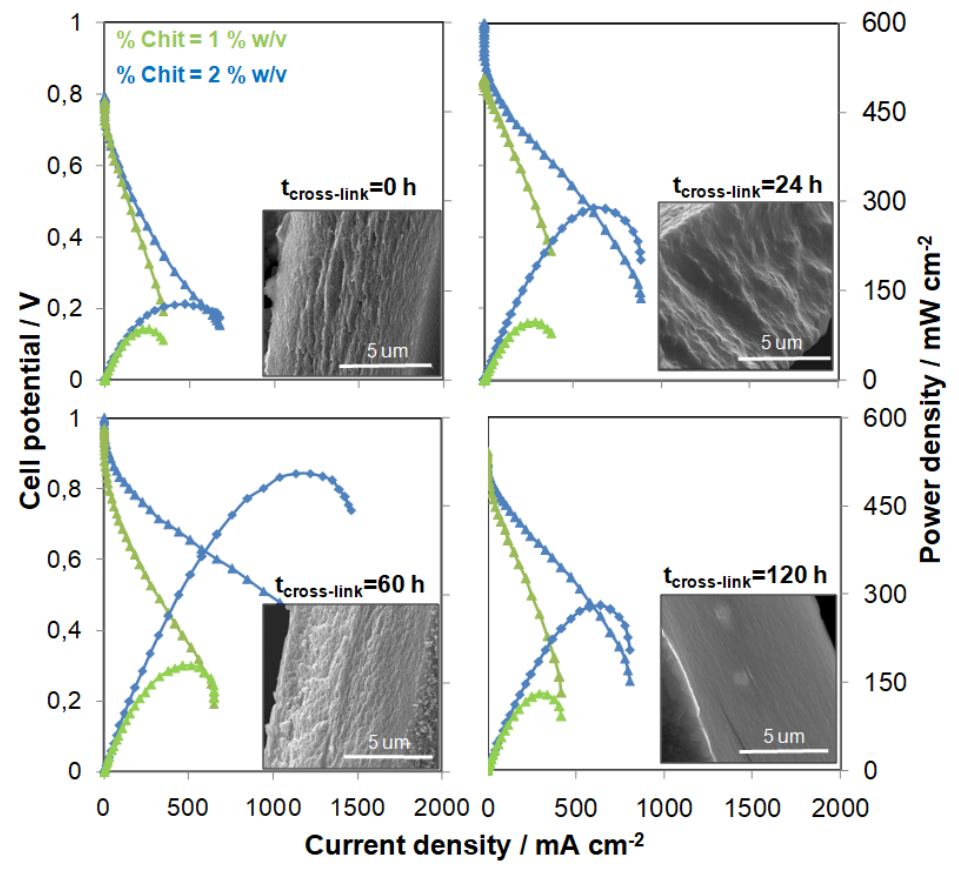
Figure 7. Polarization and power curves recorded for an H 2 / O 2 fuel cell working at 25 ◦ C cell and gas temperature and 1 mg cm − 2 Pt loading with composite Chit / PWA flat membranes prepared according to the BIG method at 1 (green line) and 2 (blue line)% wt / v Chit and different post-crosslinking step times (0, 24, 60, 120 h). Insets: Correspondent Chit / PWA flat membrane SEM cross-sectional views.